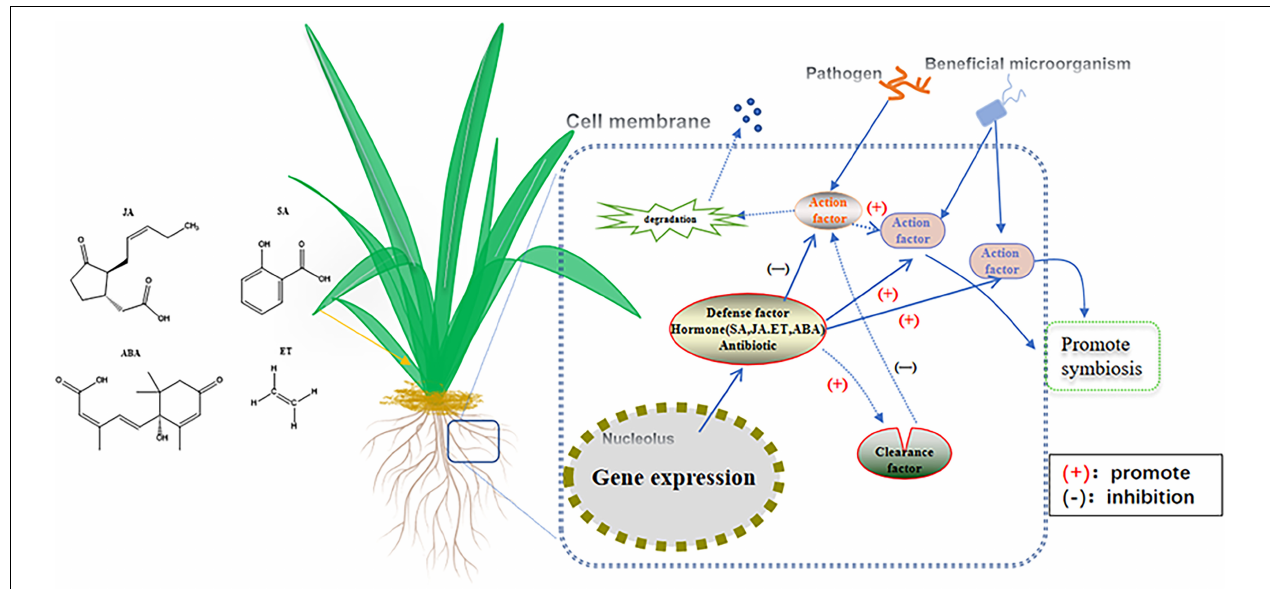
FIGURE 1 | Signal response mechanisms for promoting (+) or inhibiting (–) plant – microbial interactions. Exogenous microorganisms release action factors to infest plants, which respond with gene expression and release metabolites such as antibiotics and hormones (SA, JA, GA, ET, and ABA) to interfere with the infestation to protect